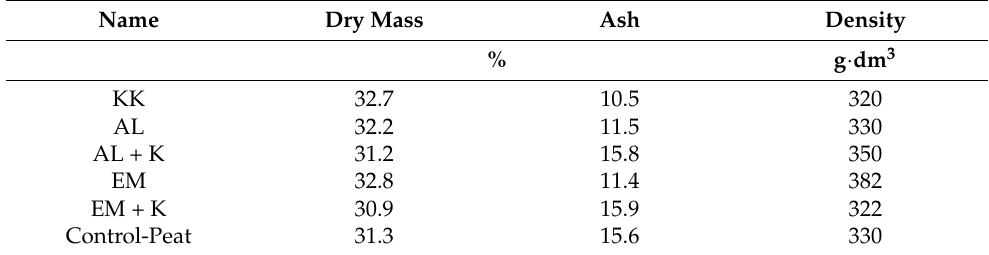
Table 2. Selected parameters of compost from reactors before mixed with peat.